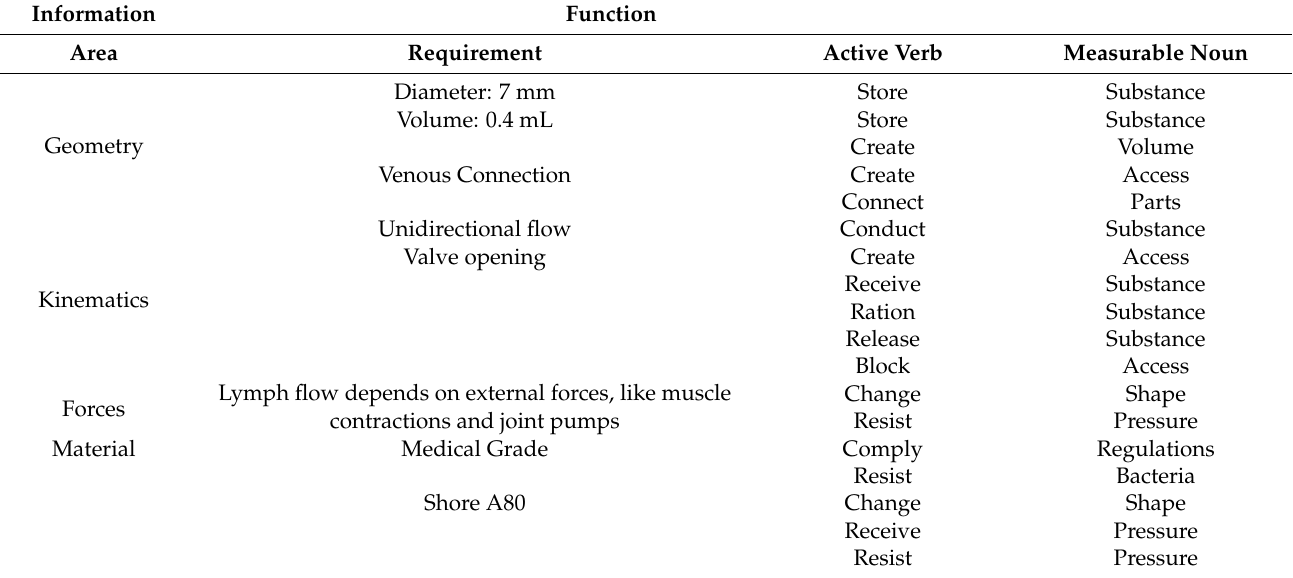
Table 1. Random list of functions according to the requirements obtained from a lymphatic vessel [26].